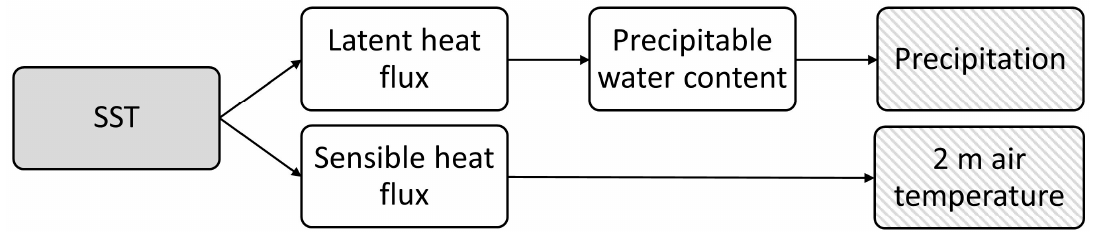
Figure 1. Connection between SST (seas surface temperature), and precipitation and 2 m temperature.